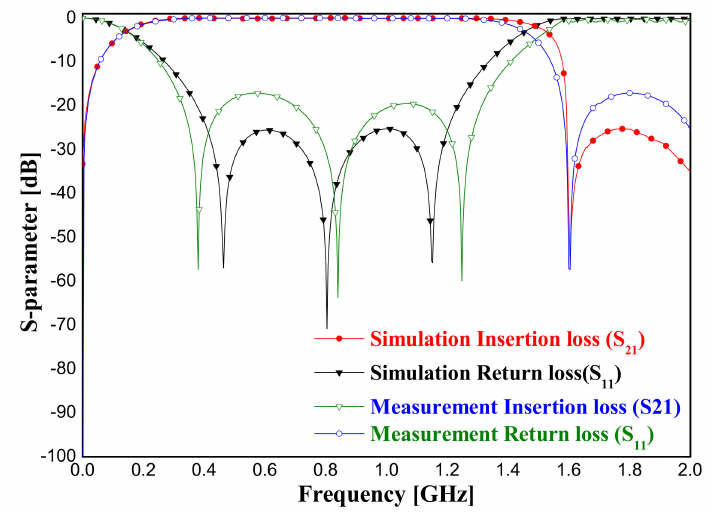
Figure 7. Simulated and measured insertion and return losses.